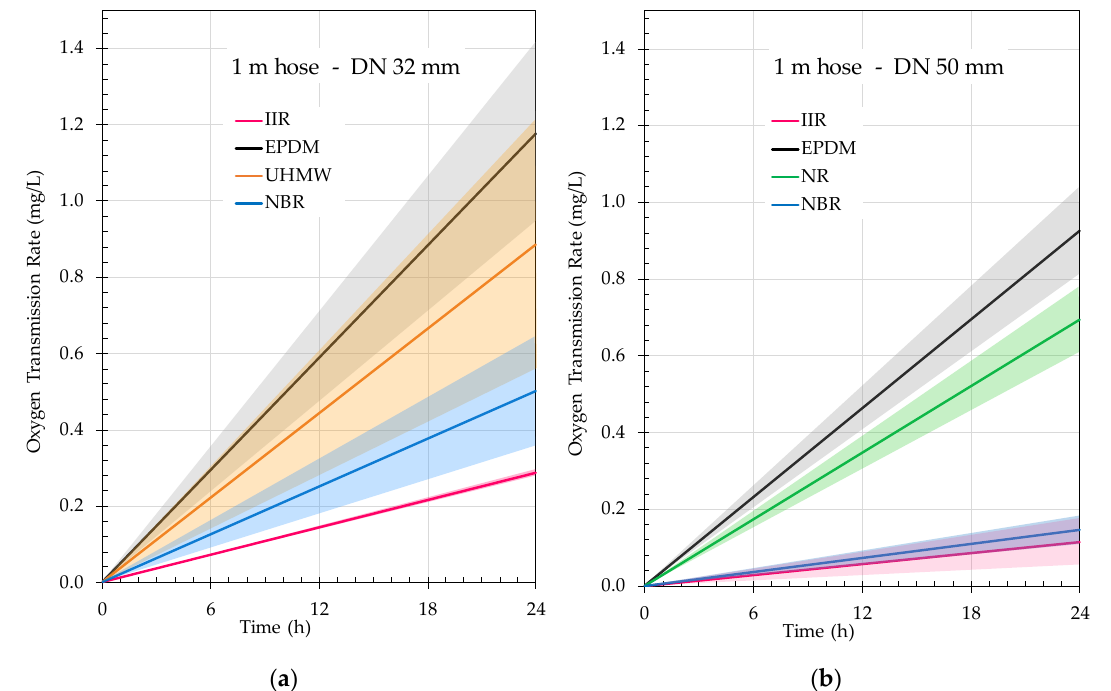
Figure 10. Comparison of OTR (mg/L · h) corrected with the volume hose for both diameters, ( a ) DN32 and ( b ) DN50; and for the different materials tested. Thin line color represents standard deviation from the mean of each material.